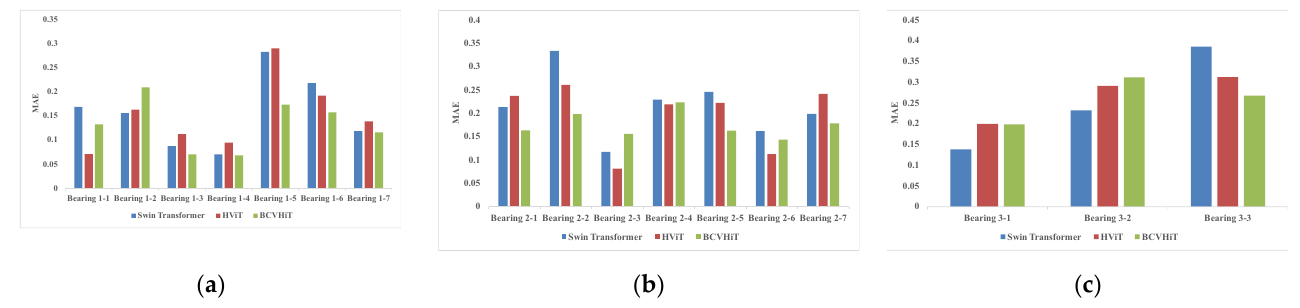
Figure 11. The MAE of different rolling bearings for each working condition in the ablation experi- ment: ( a ) Condition 1; ( b ) Condition 2; ( c ) Condition 3.